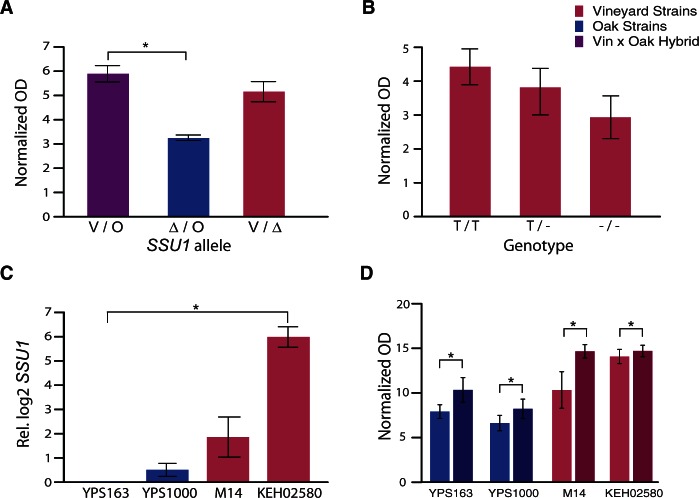
SSU1 at the Chr 8:16 translocation contributes to growth in grape juice. (A) The vineyard allele of SSU1 is responsible for grape juice QTL. The bars show average final OD600 (normalized to the starting OD600) for hybrid and hemizygous strains containing different SSU1 alleles grown in grape juice. Error bars depict standard deviation. Asterisks (*) denote statistical significance (P = 0.04, t-test). (B) Chr 8:16 translocation copy number correlates with grape juice growth in wild vineyard strains. The average final OD600 (normalized to the starting OD600) for strains grown in grape juice, averaged over vineyard strains homozygous for the translocation (T/T, N = 5), heterozygous for the translocation (T/-, N = 4), and without the translocation (‐/‐, N = 6). Error bars depict the standard error of the mean. (C) SSU1 is highly expressed in KEH02580. Average and standard deviation of SSU1 transcript abundance (measured in biological duplicate) in each strain normalized to YPS163. Asterisk (*) denotes statistical significance (P < 0.2, t-test). (D) Overexpression of SSU1 enhances growth in grape juice. Final optical density (OD600) was normalized to the starting OD600 for each parental strain (y axis) overexpressing the vineyard allele of SSU1 (dark bars) or harboring an empty vector control (light bars). Error bars depict ± standard deviation. Asterisks (*) denote statistical significance (P < 0.03, t-test).